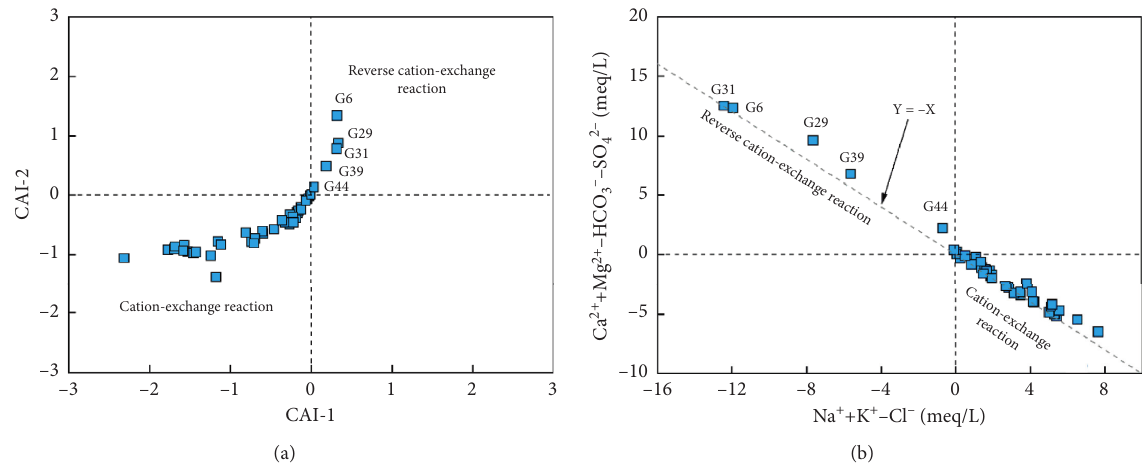
Figure 9: Scatter plots of (a) chloro-alkaline indices CAI-1 versus CAI-2 and (b) Na + +K + − Cl - versus Ca 2+ +Mg 2+ − HCO